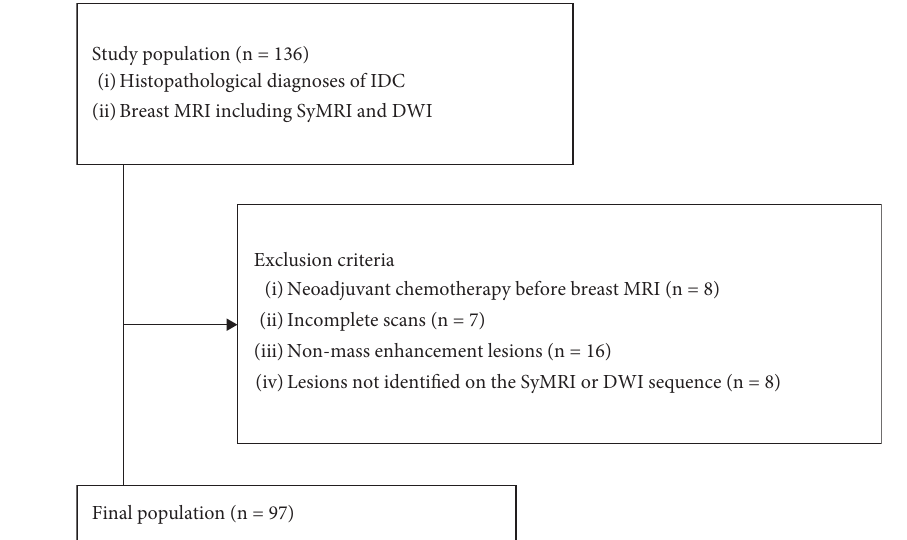
Figure 1: Flowchart of the selection of our study. Table 1: MRI sequences used in our